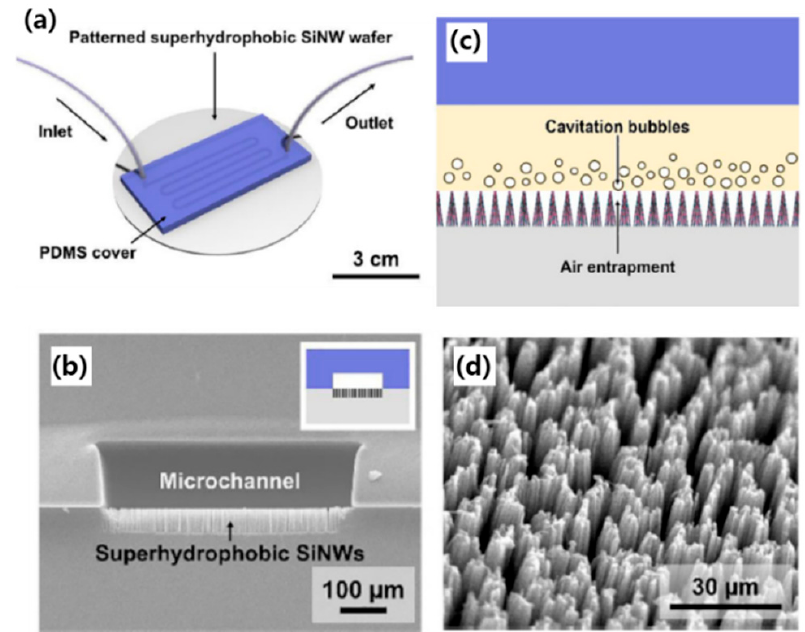
Figure 9. ( a )SchematicofsuperhydrophobicsiliconnanowireSiNWmicrofluidicdevice, ( b )cross-sectional Figure 9. ( a ) Schematic of superhydrophobic silicon nanowire SiNW microfluidic device, ( b ) cross- view of the device, ( c ) conceptual illustration of cavitation bubble generation at the air-water fluidic interface, and ( d ) SEM image of superhydrophobic SiNW bundles. Reprinted with permission from reference [61], copyright 2019,